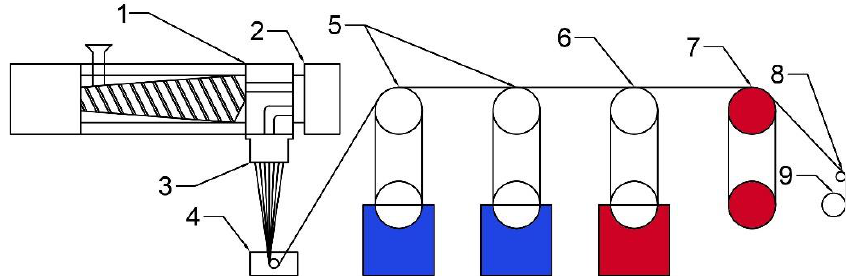
Figure 2. Schematic of laboratory equipment for dry-jet wet spinning of fibers (1 — extruder, 2